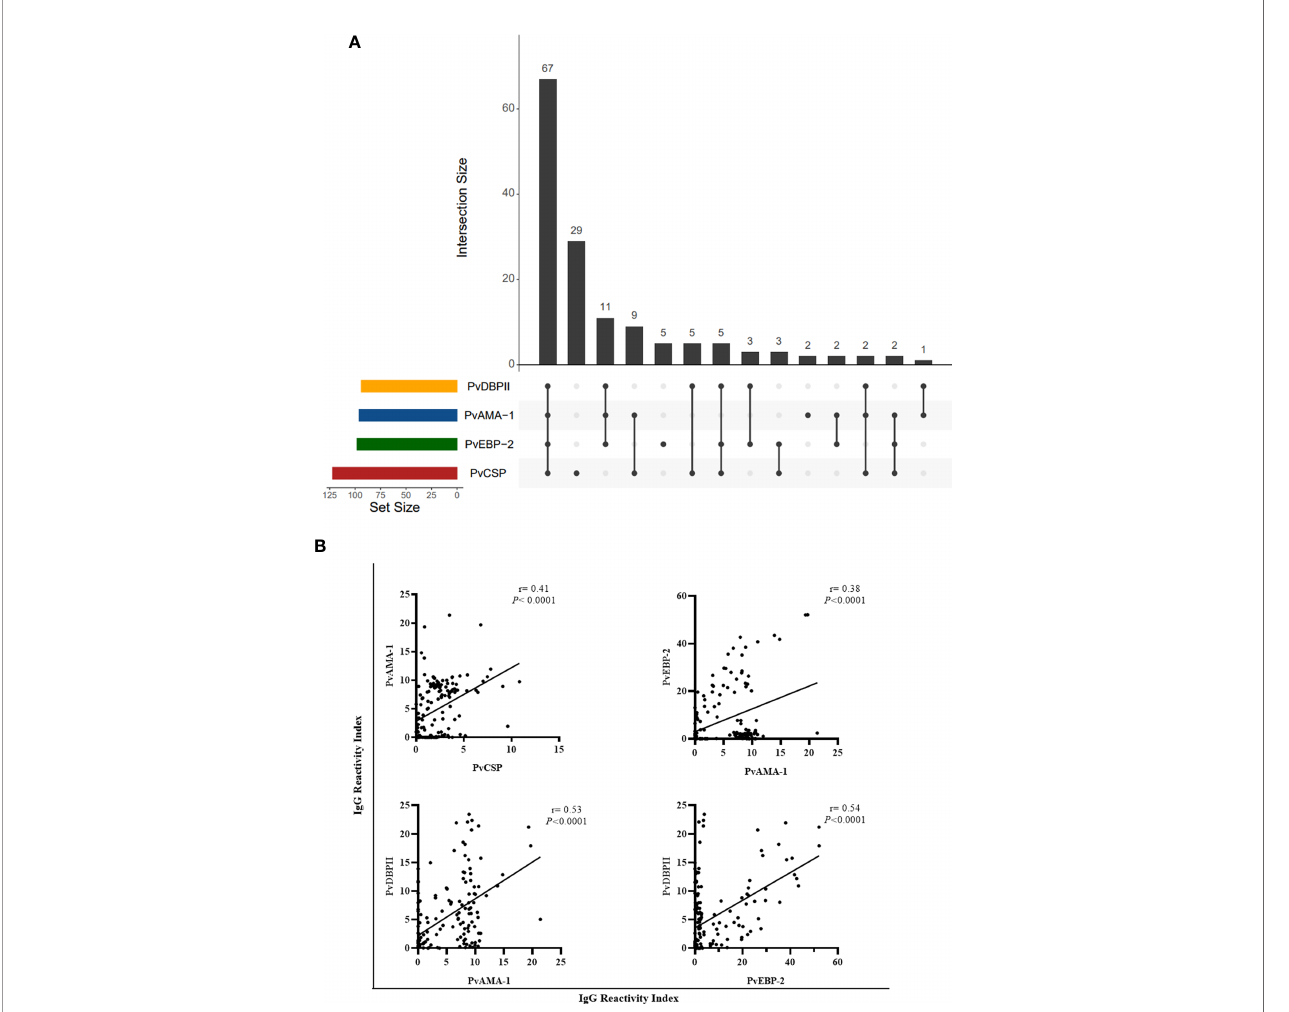
FIGURE 7 | Association between responder monkeys against pre-erythrocytic and erythrocytic antigens of Plasmodium vivax. (A) UpSetR plot of responders to PvCSP and P. vivax blood stage antigens among all responder animals. (B) Signi fi cant correlation between reactivity index of responders to PvCSP and P. vivax blood stage antigens and among RI of blood stage antigens. Data expressed the value of r (Sperman ’ s rack correlation). PvCSP: CSP repeats representing P. vivax CSP repeats (VK210, VK247, and P. vivax -like); PvDBPII: P. vivax Duffy Binding Protein region II; PvAMA-1: P. vivax Apical Membrane antigen – 1; PvEBP-2: P. vivax Erythrocyte Binding